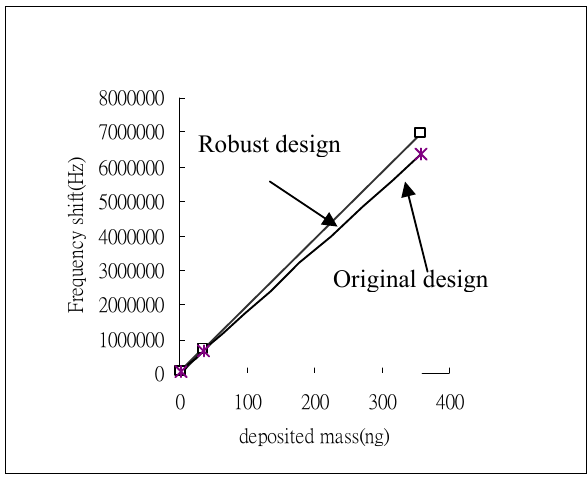
Figure 9. Comparisons of original and robust design for sensitivity β